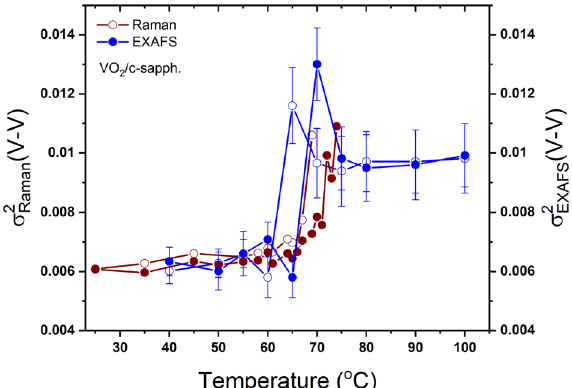
Figure 8. Temperature-dependent mean square relative displacement determined from our Raman data and from EXAFS measurements 21 . Filled symbols correspond to heating cycles and open symbols to cooling cycles. Wine symbols are for Raman measurements and blue symbols for